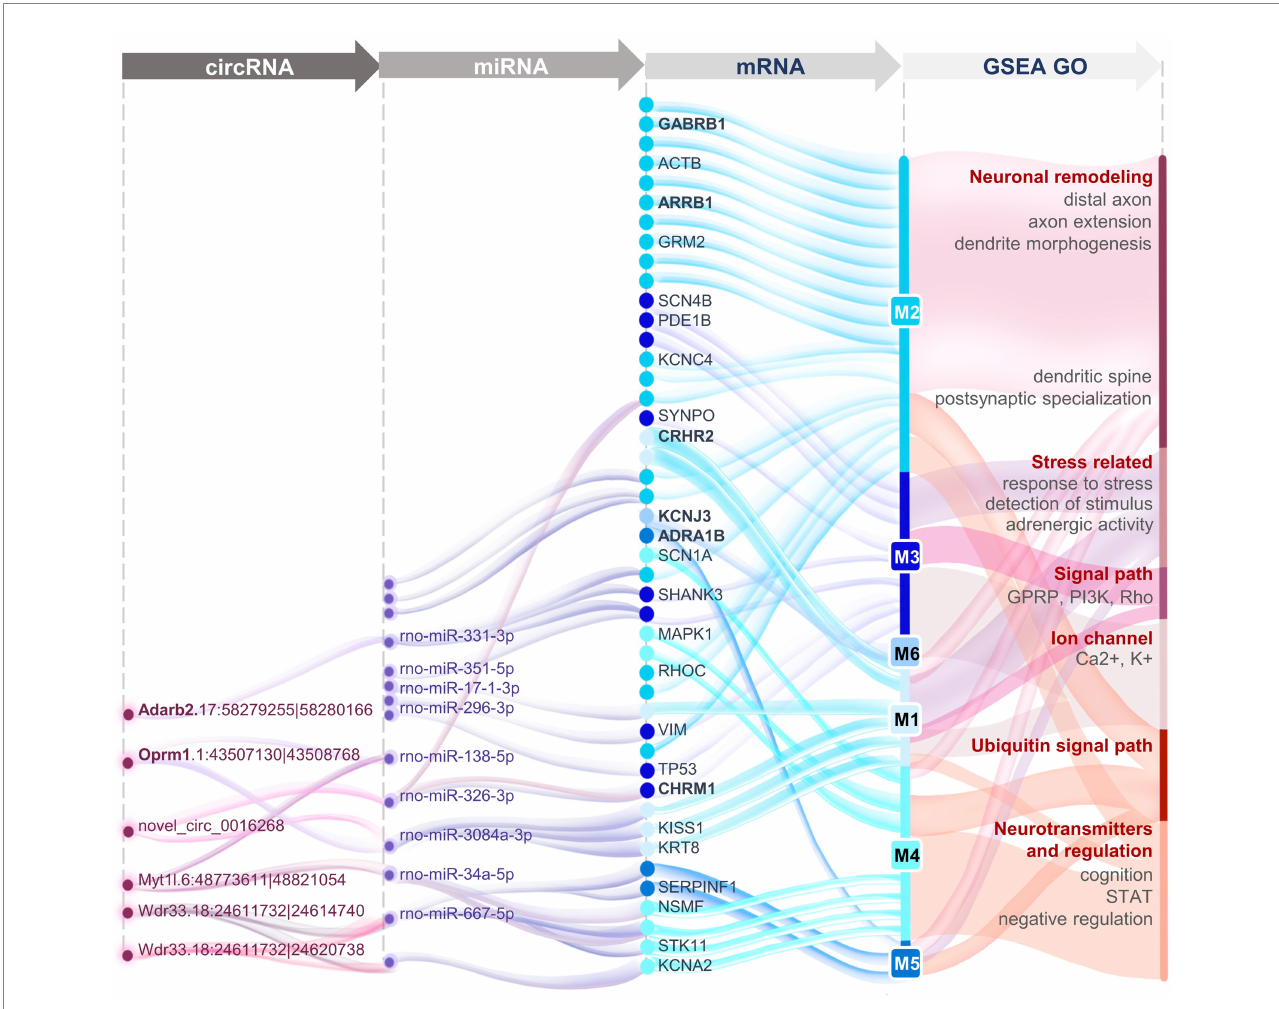
FIGURE 7 Panoramic view of the circRNA-miRNA-mRNA interaction networks in the PVN revealing the transcriptomic mechanisms of EA treatment for surgery- induced